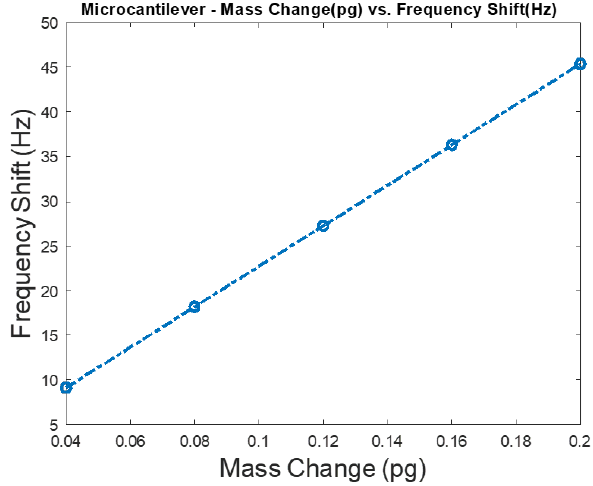
Figure 6. Sensitivity analysis for a silicon microcantilever mass sensor when the target adsorbed mass is increased from 0.16 to 0.4 pg with a step size of 0.04 pg. The investigated sensor has a 40 μm length, a 20 μm width, a 0.5 μm thickness, a cavity height of 0.5 μm, and is made of silicon. A bias of 3 V DC, which is chosen close to the device’s pull-in voltage, is applied to the microcantilever mass sensor.